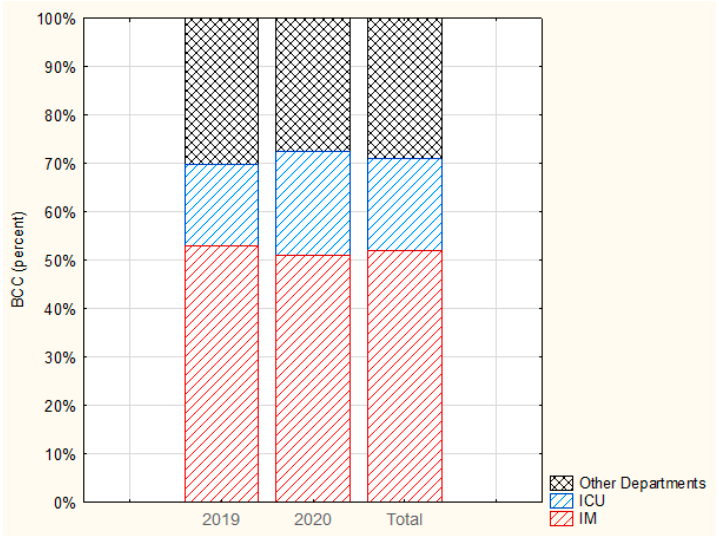
Figure 1. Percentage of BCC in IM, ICU and Other Departments in 2019 and 2020.